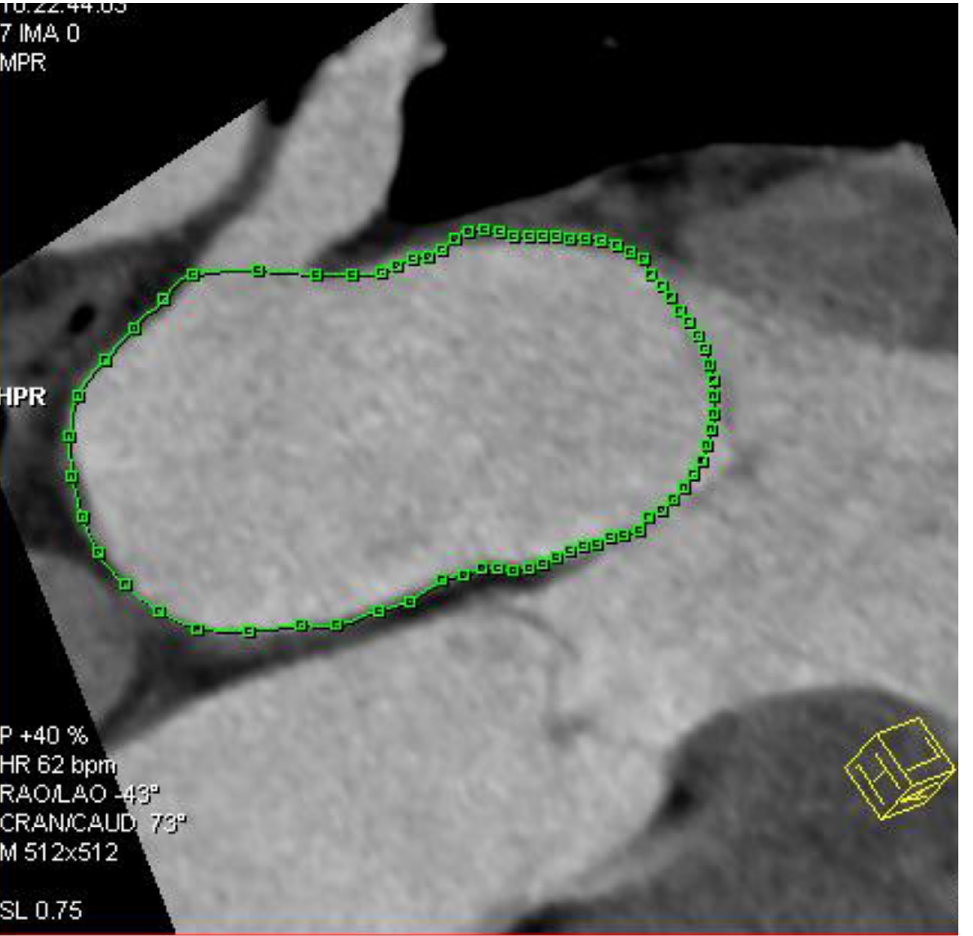
Fig 1. 2D image of LA. Two-dimensional image illustrating how to delineate left atrial endocardium during postprocessing LA volume